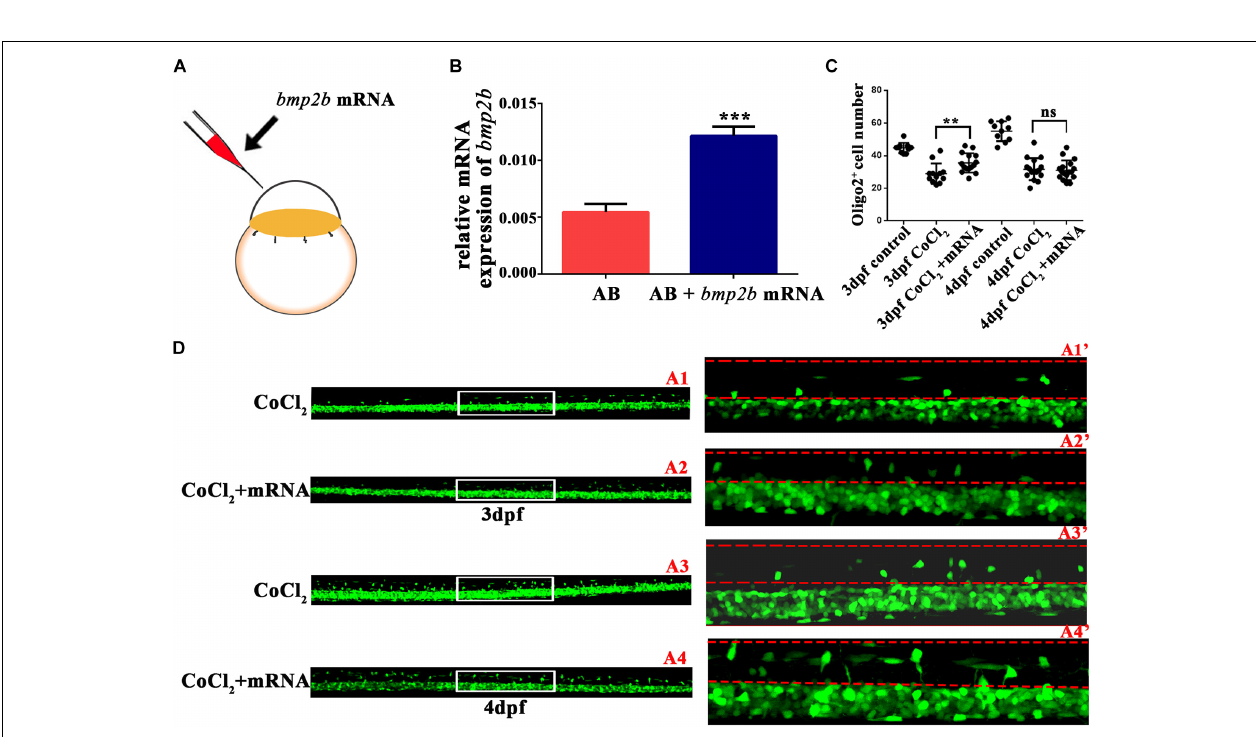
FIGURE 5 | Bmp2b mRNA reversed the reduction in the number of olig2 + cells migrating to the dorsal area. (A) Bmp2b mRNA was injected into one-cell embryos. (B) qRT-PCR analysis showed that bmp2b gene expression increased, validating the rescue effect. (C–D) bmp2b mRNA reversed the reduction in the number of dorsally migrated olig2 + cells at 3 and 4 dpf. A1 (cid:48) , A2 (cid:48) , A3 (cid:48) , and A4 (cid:48) are the magnified pictures of the white boxes in A1, A2, A3, and A4. Scale bars: A1–A4, 50 µ m and A1 (cid:48) –A4 (cid:48) , 10 µ m. ∗ P < 0.05; ∗∗ P < 0.01; ∗∗∗ P < 0.001. Error bars represent S.E.M.